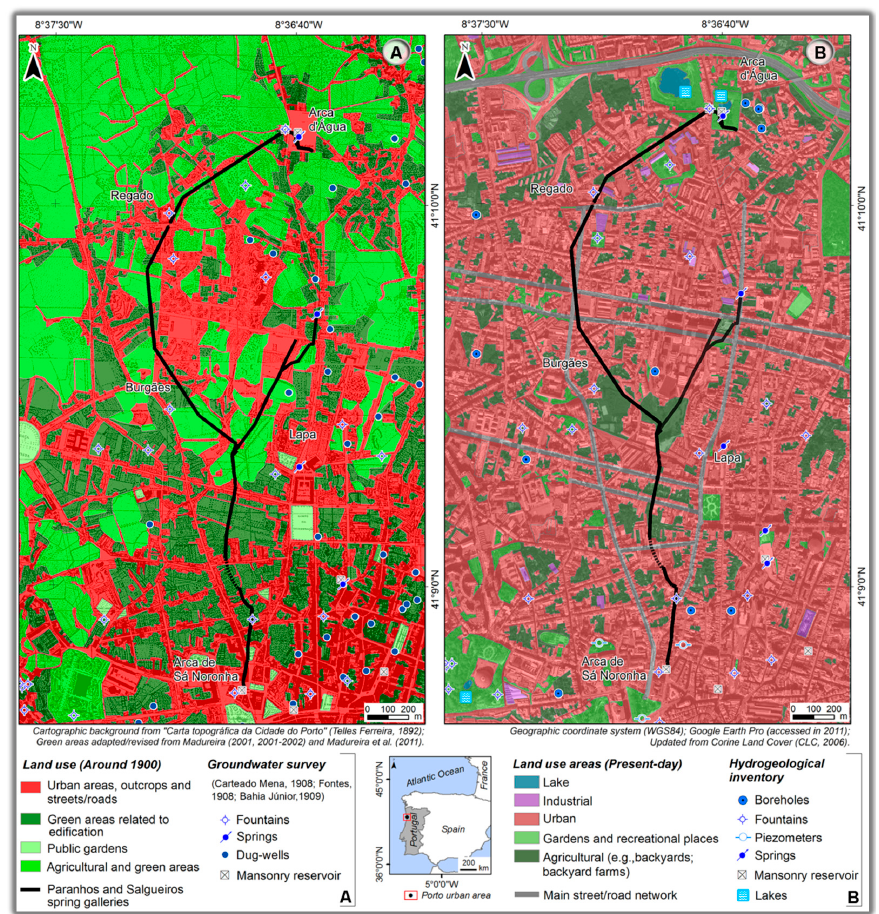
Figure 2. Land use areas in the surroundings of Paranhos and Salgueiros spring galleries. ( A ) Around 1900: main sources of water supply at the beginning of the 20th century are also presented; ( B ) Present-day; hydrogeological